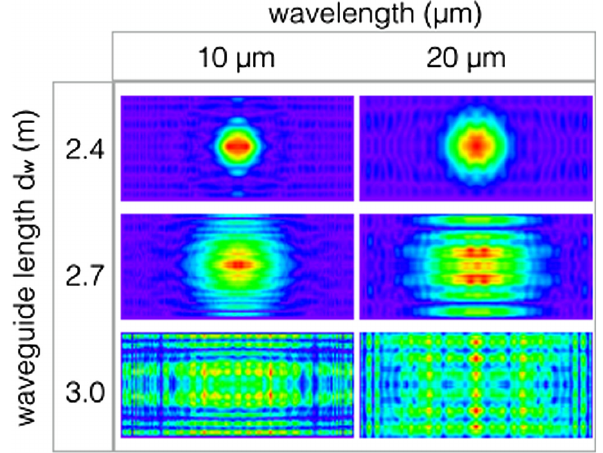
FIG. 13. Diffraction losses L various wavelength of the laser.